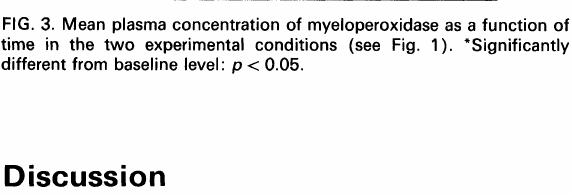
FIG. 3. Mean plasma concentration of myeloperoxidase as a function of time in the two experimental conditions (see Fig. 1). *Significantly different from baseline level" p <